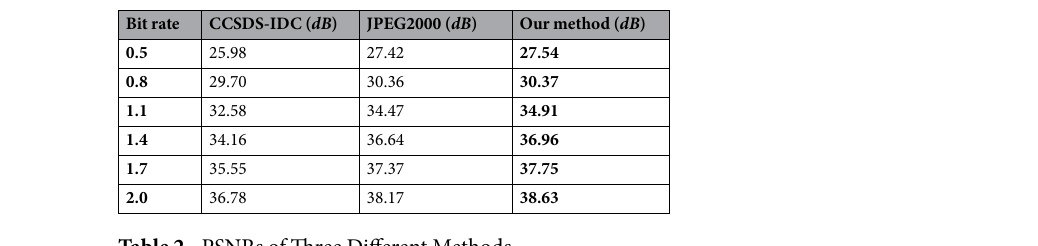
Table 2. PSNRs of Three Different Methods.